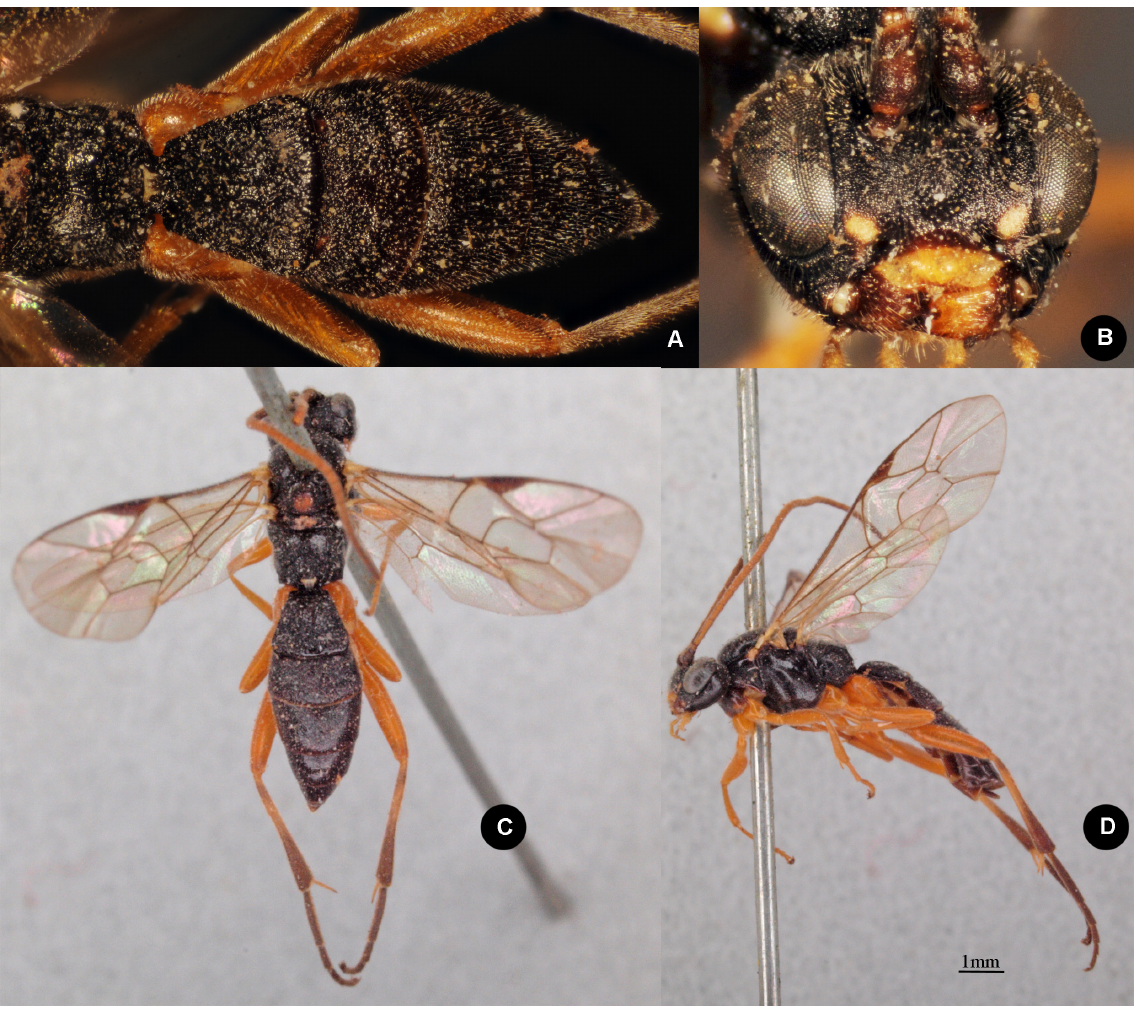
Fig. 11. Rhinotorus ovalis (Davis, 1897), lectotype, ♀. A . Metasoma dorsally. B . Face. C . Habitus dorsally. D . Habitus